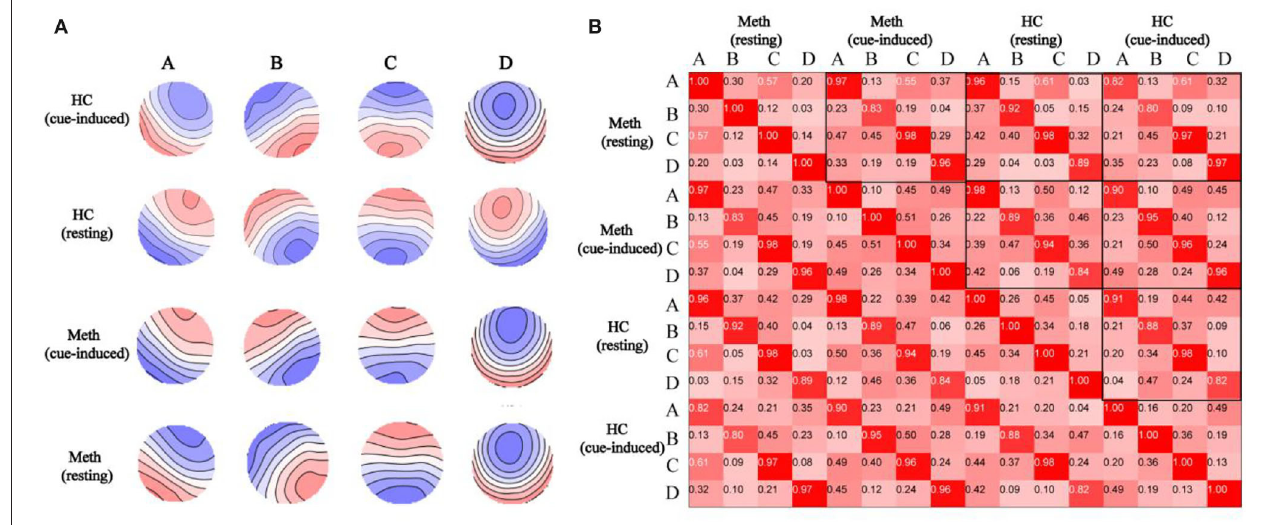
FIGURE 2 | Spatial correlations are depicted between microstate topographies. (A) Topographies of microstate in healthy control (HCs) with cue-induced condition, HCs with resting condition, Meth-dependent patients with cue-induced condition, and Meth-dependent patients with resting condition. The topographies are labeled as microstate classes (A–D). Note that polarity (blue vs. red) is ignored in the microstate definition. (B) Spatial correlations between microstate topographies (A–D) identified from separate topographies of resting or cue-induced conditions in each group.